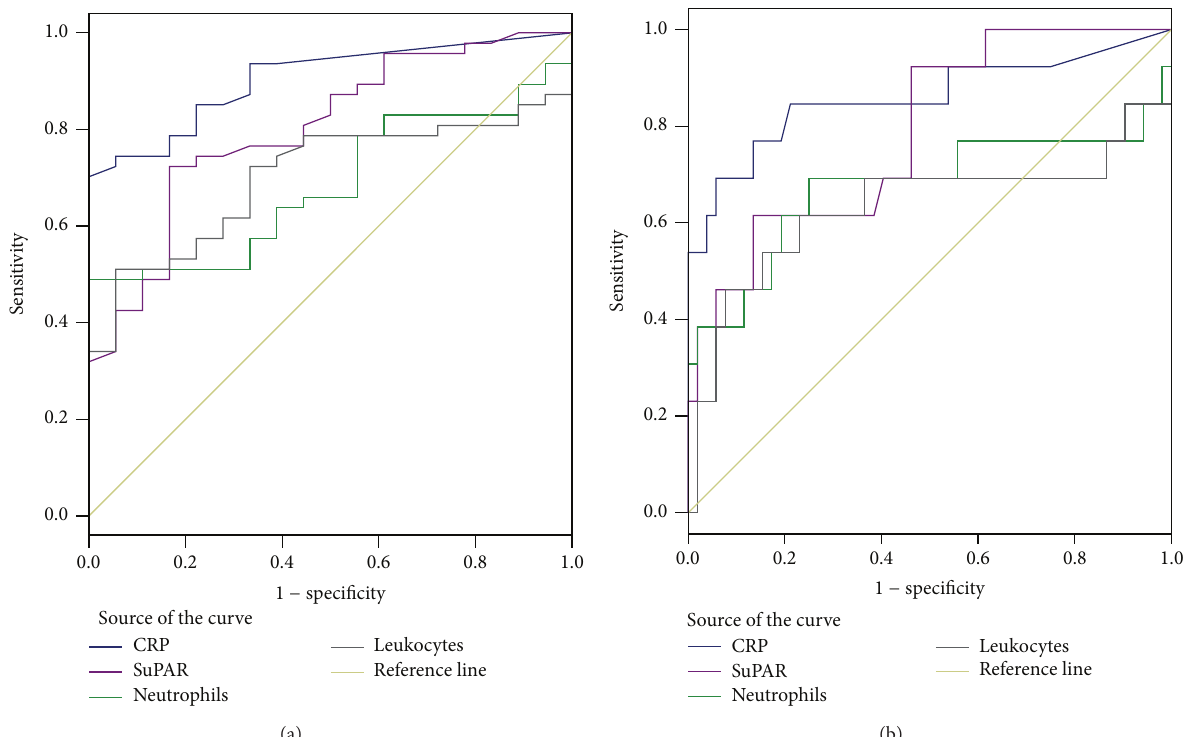
Figure 3: ROC curves for suPAR, CRP, WBC count, and ANC on admission for prediction of infection (Figure 3(a)) or sepsis (Figure